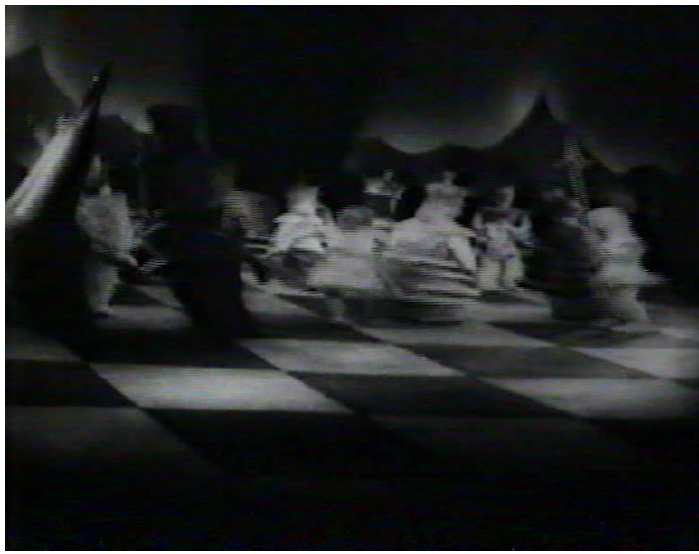
Figure 7. In Puttin’ on the Ritz , Alice, through the looking glass, in a distorted